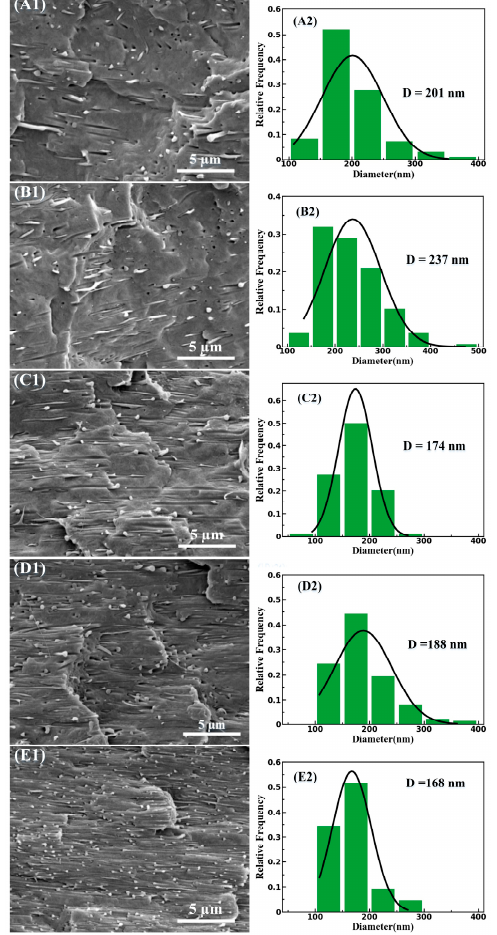
Figure 3. SEM micrographs of the cryo-fractured surfaces of the cold-drawn PBS/PLA composites with 3 wt % (A1), 5 wt % (B1), 10 wt % (C1), 15 wt % (D1), and 20 wt % (E1) of PLA. The statistical analyses with respect to the distribution of the diameters of PLA domains as shown in (A2), (B2), (C2), (D2) and (E2), respectively. D refers to the average diameter of PLA domains.